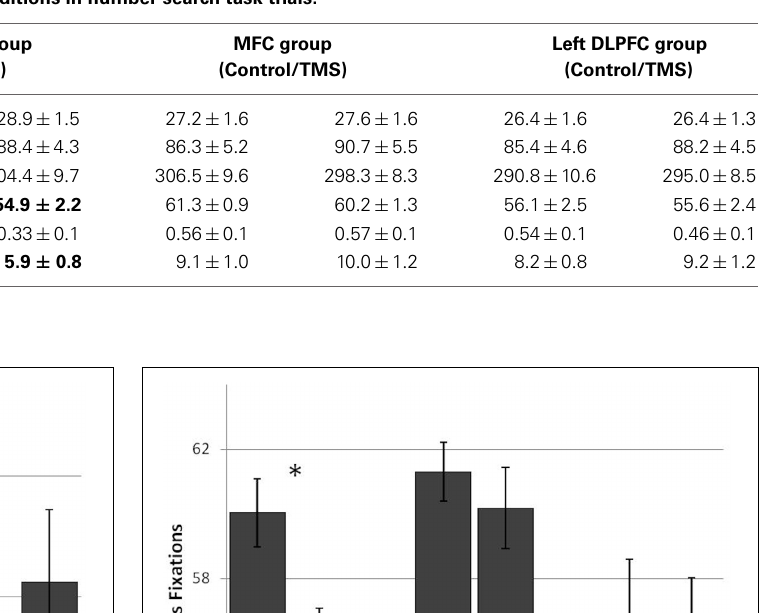
Table 1 | Descriptive statistics (mean, SE ) in the right dorsolateral prefrontal cortex group ( n = 18), MFC group ( n = 18) and left dorsolateral prefrontal cortex group ( n = 18) for control and TMS conditions in number search task trials.